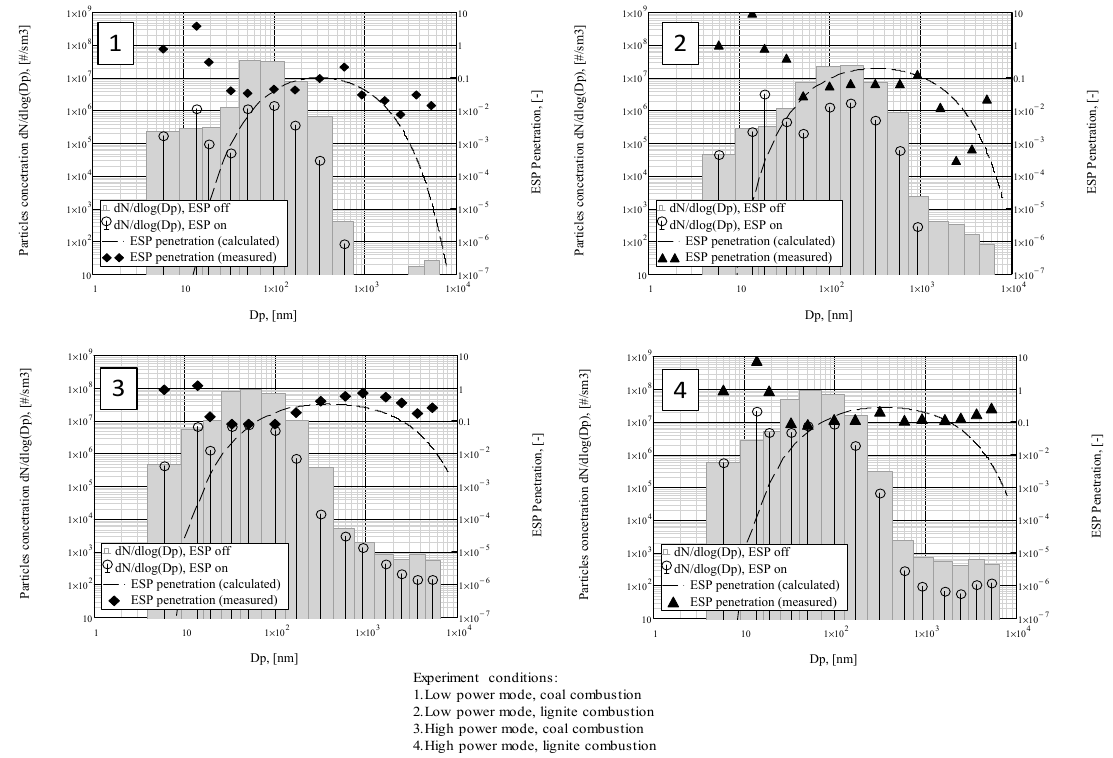
Figure 6. Particle size distribution at ESP on/off regimes and ESP penetration.